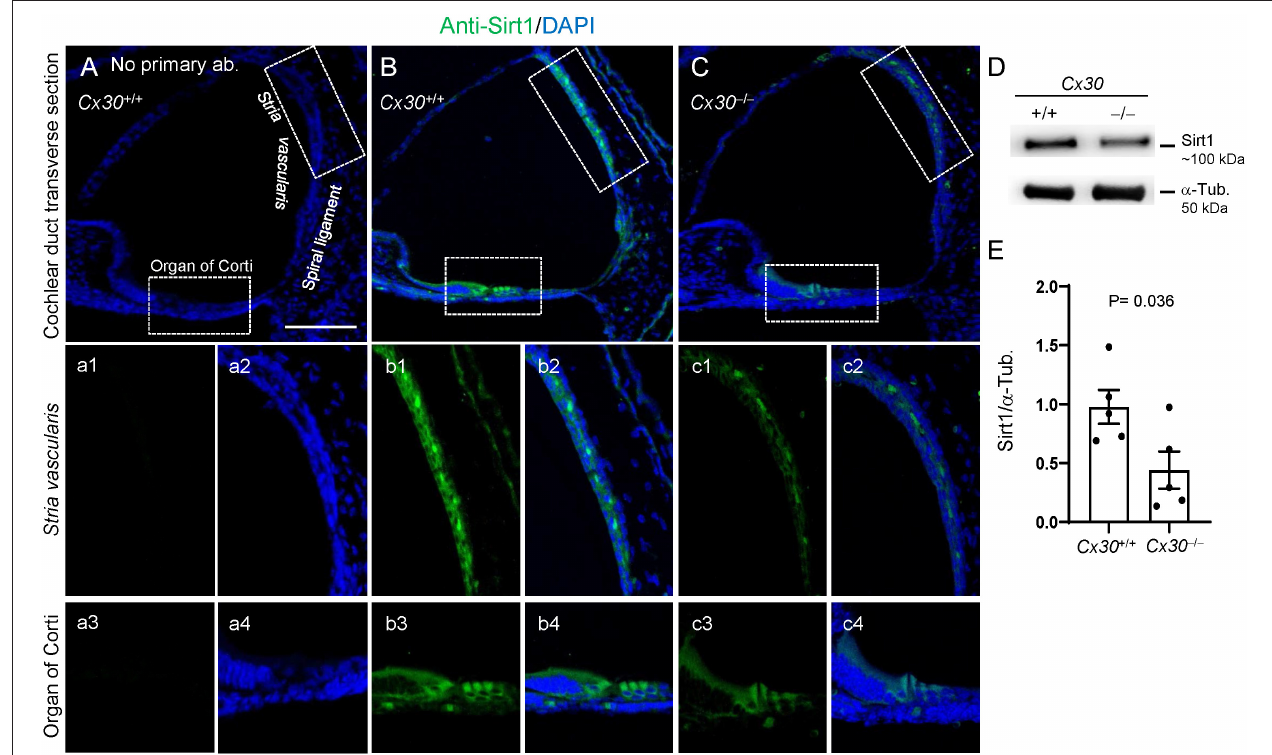
FIGURE 3 | Sirt1 expression in Cx30 + / + and Cx30 − / − cochleae at P5. (A–C) Representative images of immunofluorescence analysis with Sirt1-selective antibodies in the cochlear sensory epithelium and lateral wall of Cx30 + / + and Cx30 − / − (B,C) specimens. Images of negative control performed by omitting primary Sirt1 antibody are shown in (A) . (a1–c4) Higher magnification images of the OC and SV (dotted box in A–C ) showing separately Sirt1 fluorescence (a1,b1,c1,a3,b3,c3) and merged Sirt1/DAPI nuclei staining (a2,b2,c2,a4,b4,c4) . Scale bar: 100 µ m. (D) Representative western blot immunoreactive bands quantifying the expression of Sirt1 in Cx30 + / + and Cx30 − / − cochlear lysates. (E) Histograms indicate optical density values (mean ± SEM) of the western blots normalized to tubulin levels. Full-scan Western blot images are shown in Supplementary Figure 5 .